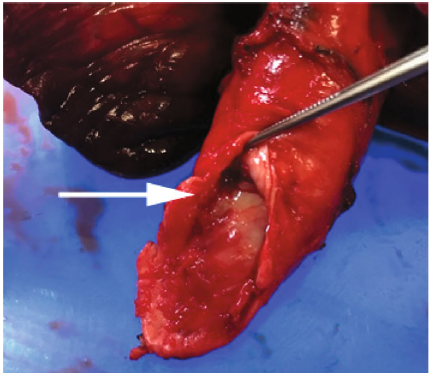
Figure 3: An occlusive tumor in the main pulmonary artery (arrow) of resected specimen.